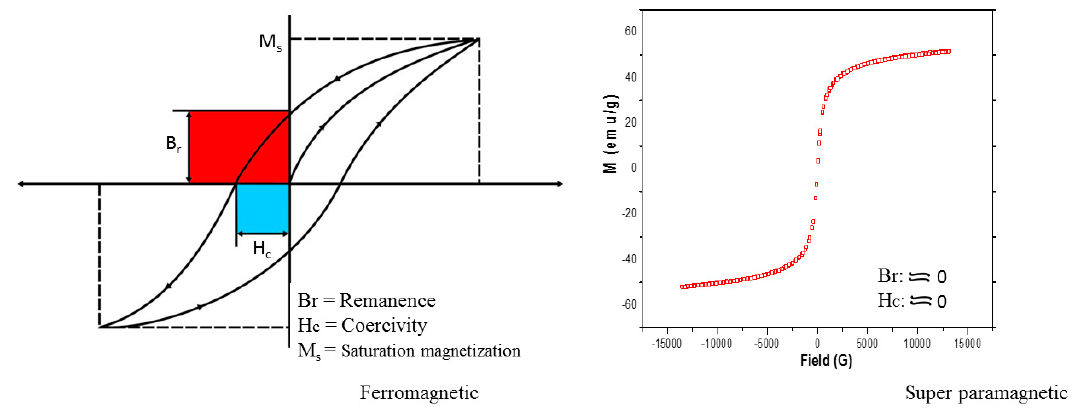
Figure 1. Hysteresis loops for ferromagnetic material and magnetite nanoparticles.